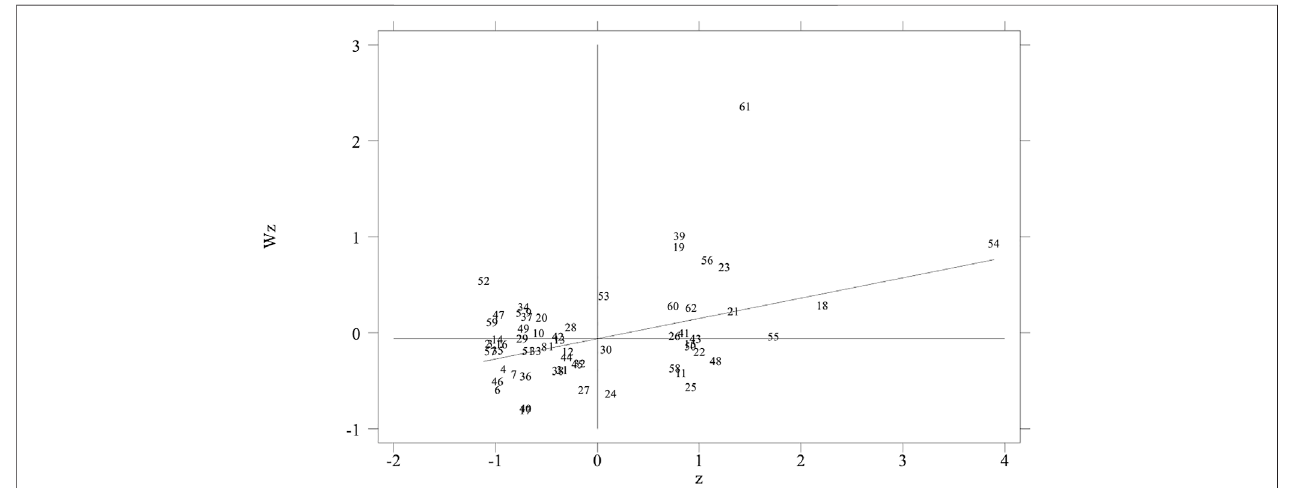
FIGURE 4 | Moran scatter plot of eco-ef fi ciency in